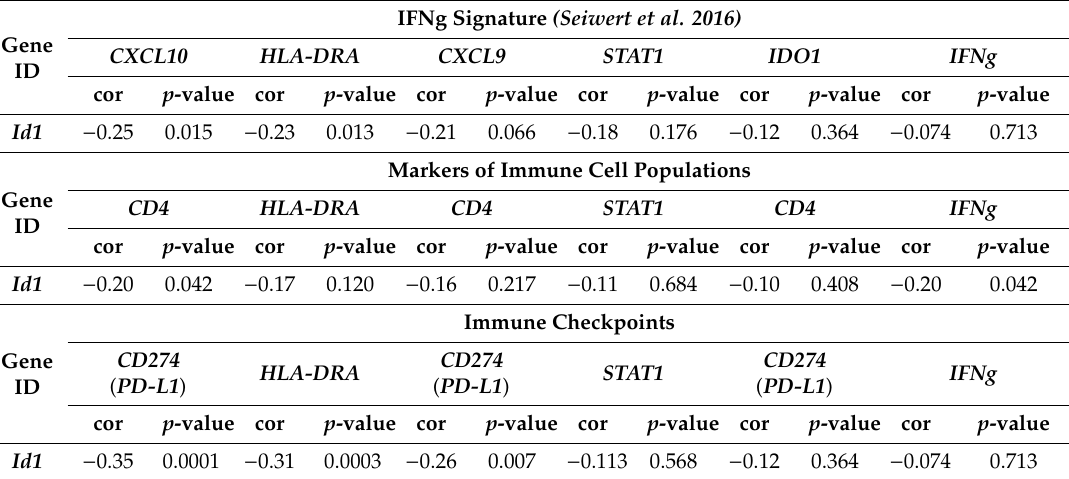
Table 1. Id1 expression correlation with immune response markers in the TCGA data